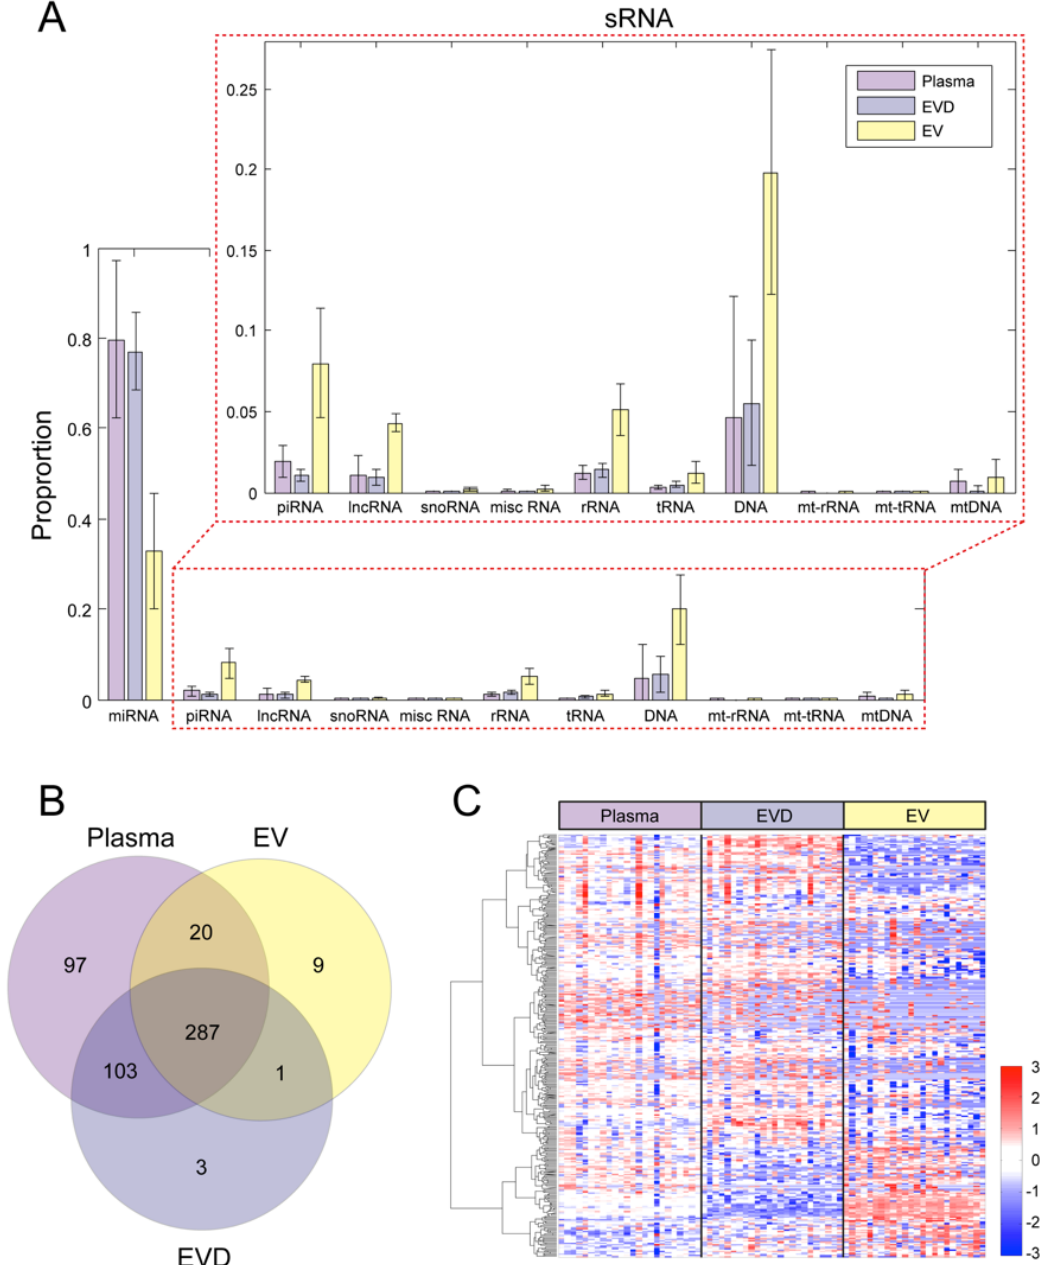
Figure 1. Different small RNA profiles in plasma, EV, and EVD samples. ( A ) The average small RNA compositions of the 24 subjects. ( B ) The number of the detected microRNAs (miRNAs) in each sample type. ( C ) The abundance profiles of the 287 miRNAs detected in all sample type.